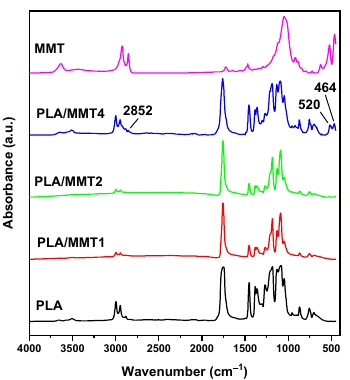
Figure 5. FTIR spectra of PLA, its nanocomposites with MMT, and neat MMT .